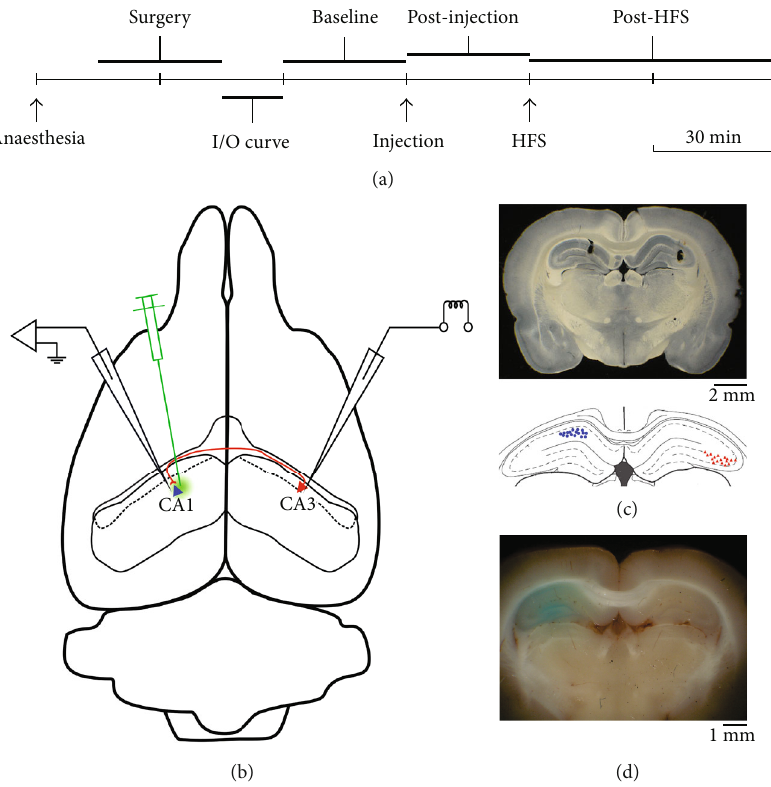
Figure 1: Experimental timeline and preparation. (a) Timeline indicating the experimental procedures during a recording session. (b) Diagram of a rat brain illustrating microelectrode cannula (for local fi eld potential recording and microinjection in left CA1) and stimulating electrode (in right CA3) locations. (c) Panoramic photograph of an obliquely illuminated coronal brain slice containing representative electrolytic lesions made by passing current through recording (left) and stimulating (right) electrodes (upper panel), paired to a corresponding coronal diagram of the hippocampus (extracted and modi fi ed from the bregma: -3.6 mm diagram of Paxinos ’ rat brain atlas), summarizing recording (left, blue circles) and stimulating (right, red triangles) electrode placement in each experimental subject. (d) Panoramic photograph of a brain block containing methylene blue-coloured left hippocampus, attesting adequate di ff usion of the injected